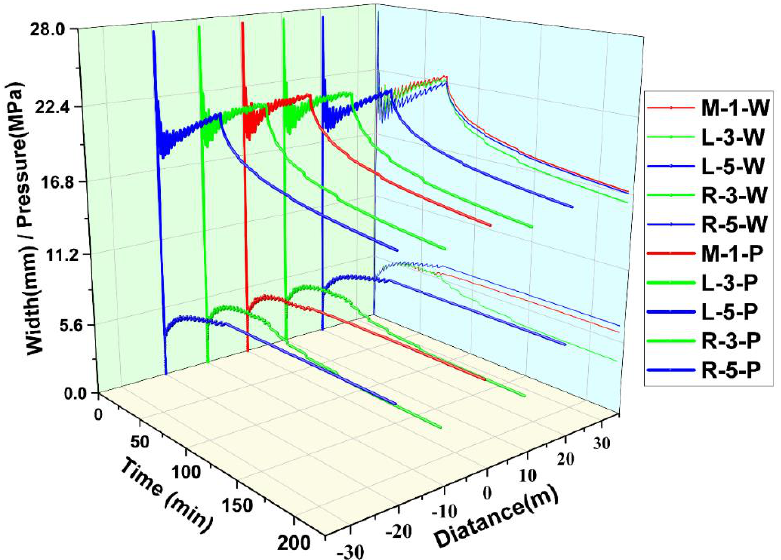
Figure 8. Curves of fracture width and injection point pressure. The upper curve represents the pressure at the injection point, the lower curve represents the width of the fracture, and the red curve represents the intermediate injection point. The lateral curve is the projection of pressure and width of the five fractures.